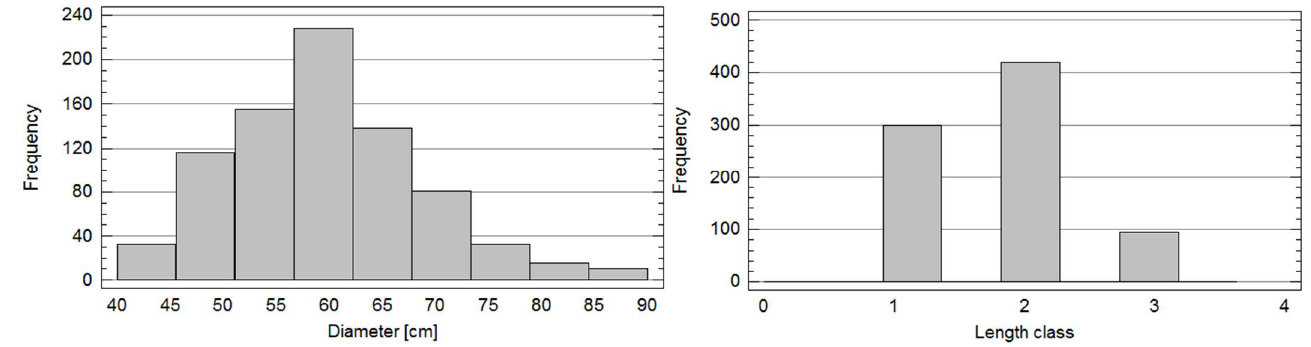
Figure 2. Frequency distribution of 817 high-priced spruce logs by diameter ( left ) and length classes ( right ).